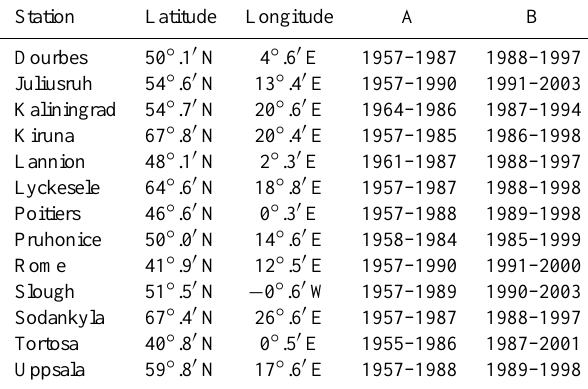
Table 1. List of ionospheric stations used for the development of IFERM: the range of years considered to obtain the set of regression coefficients (column A) and the range of years taken into account for testing (column B) are shown for each ionospheric observatory.